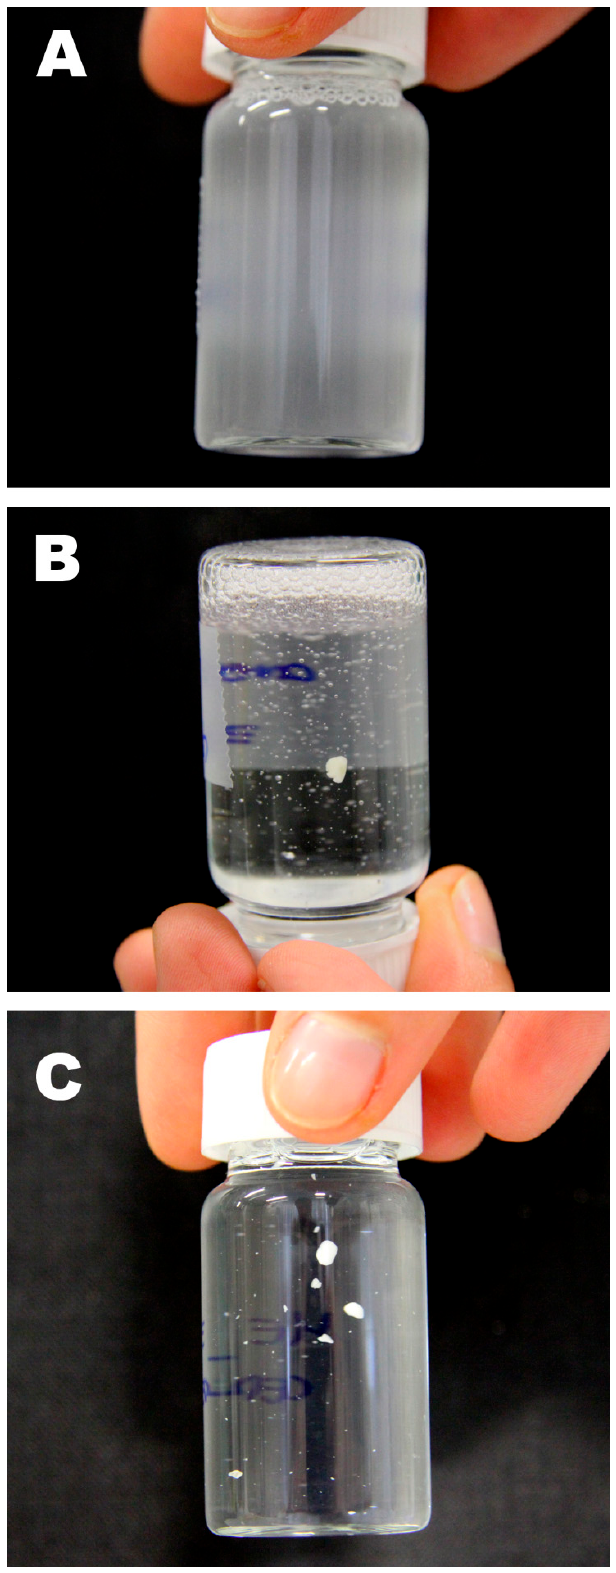
Figure 4. ( A ) 5 mg of paraffin emulsified in 20 mL of microemulsion; ( B ) 5 mg of beeswax swollen by 20 mL of microemulsion; ( C ) 5 mg of ceresin swollen by 20 mL of microemulsion.